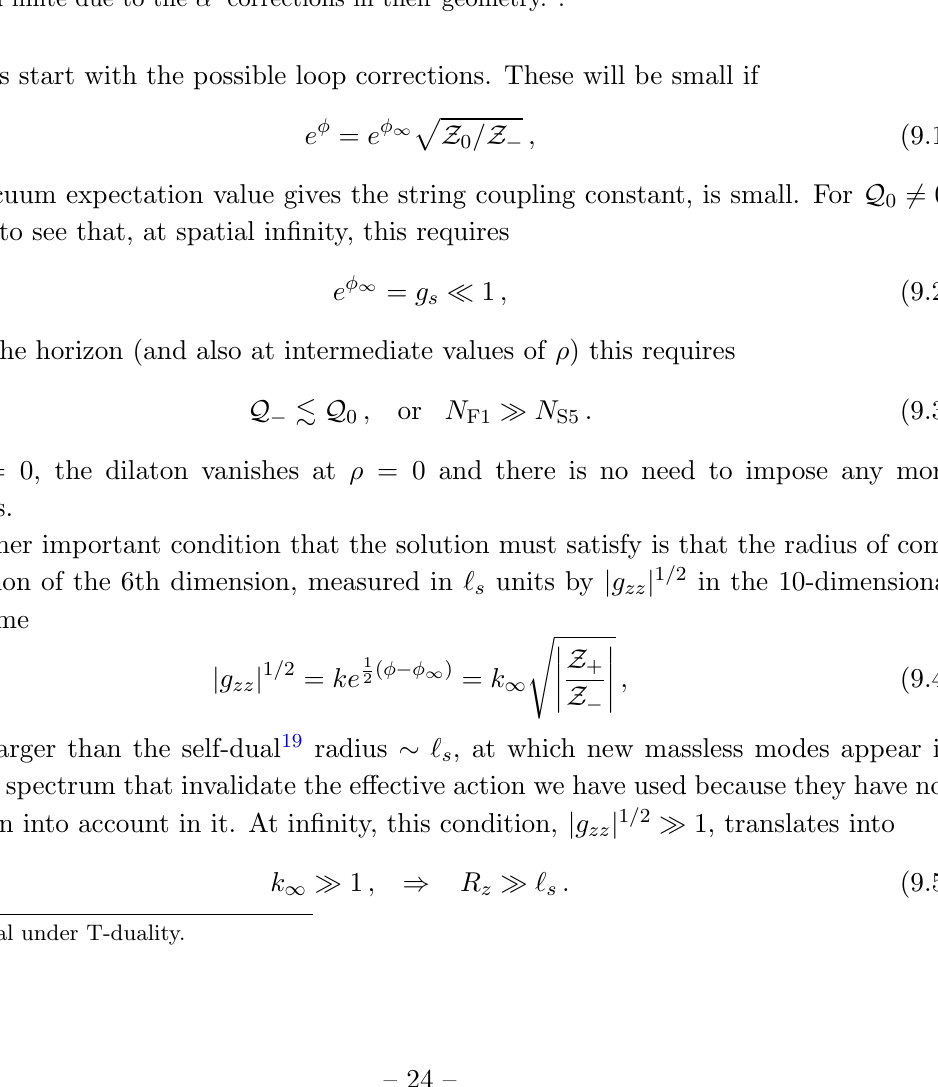
Figure 1 . Location in Q + - Q (cid:0) charge space of the small black holes ( Q 0 = 0) whose horizon area is rendered (cid:12)nite due to the (cid:11) 0 corrections in their geometry.